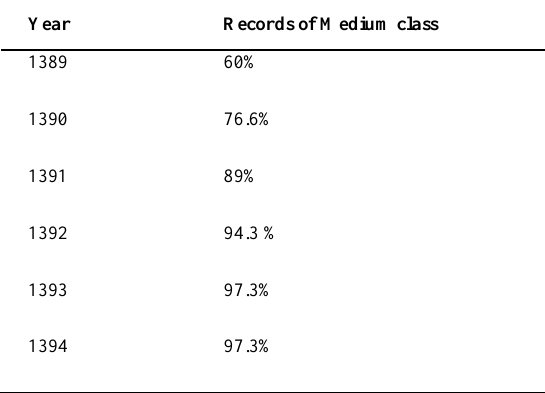
Table 10. Pasargad Bank performance.